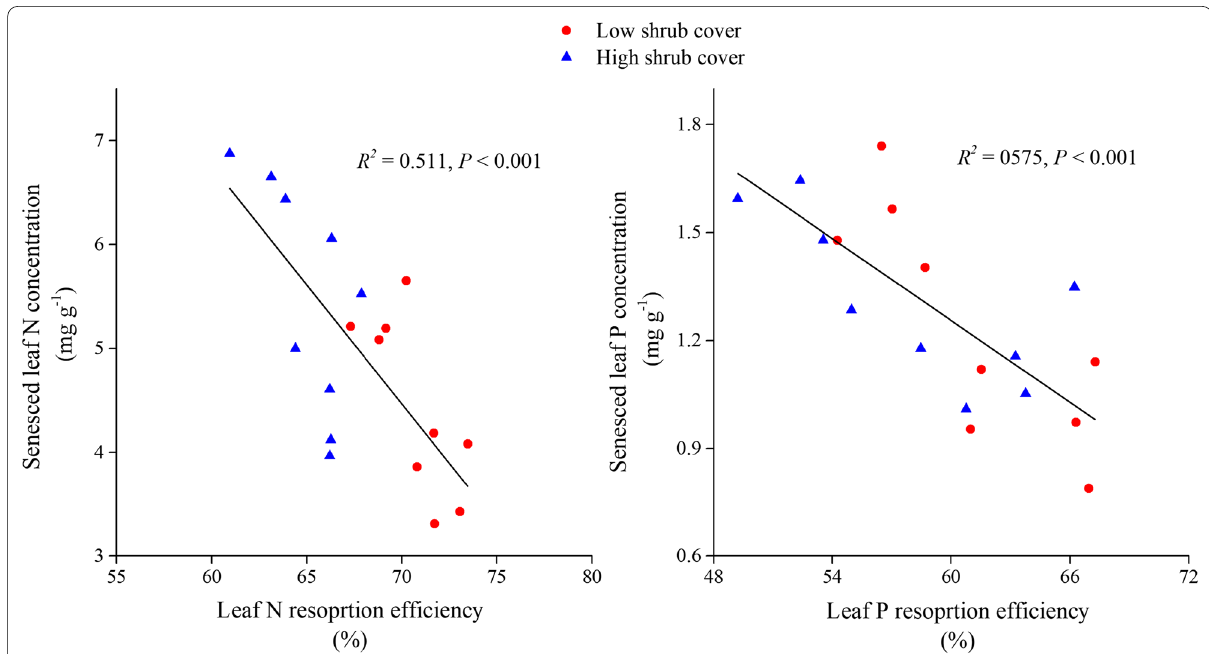
Fig. 3 The relationships between senesced leaf nutrient concentrations and leaf nutrient resorption efficiency at the plant growth form level in freshwater wetlands of Northeast China